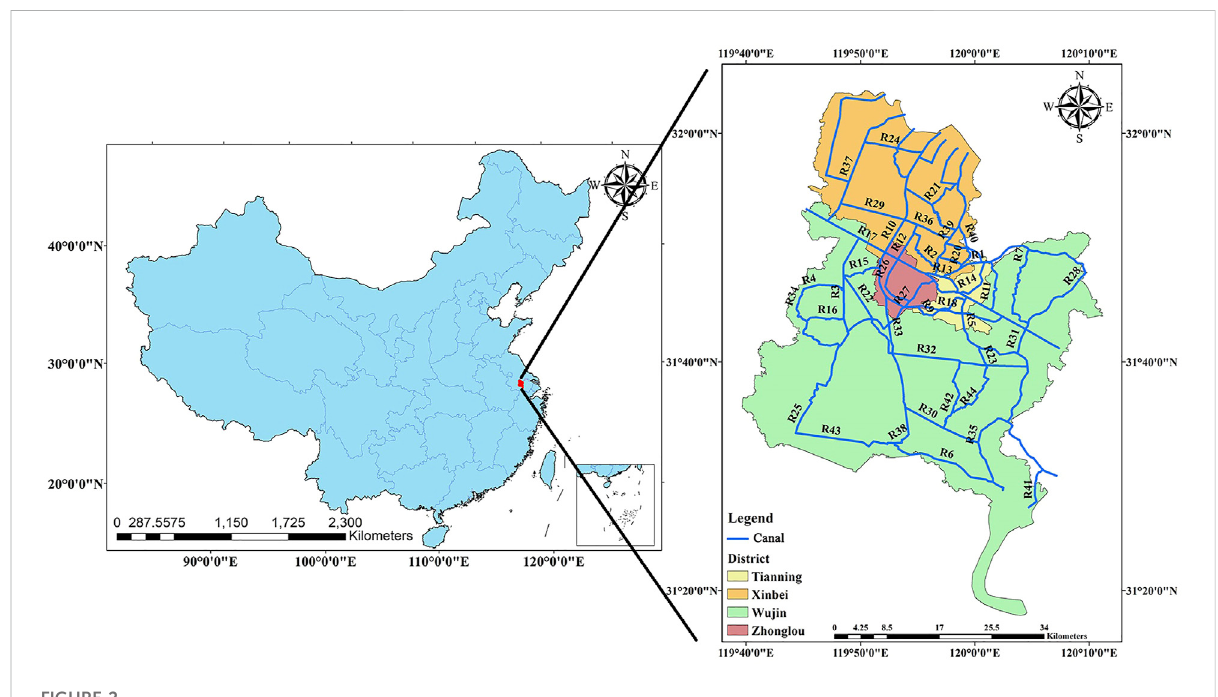
FIGURE 2 Location of geographic space of canals in Changzhou